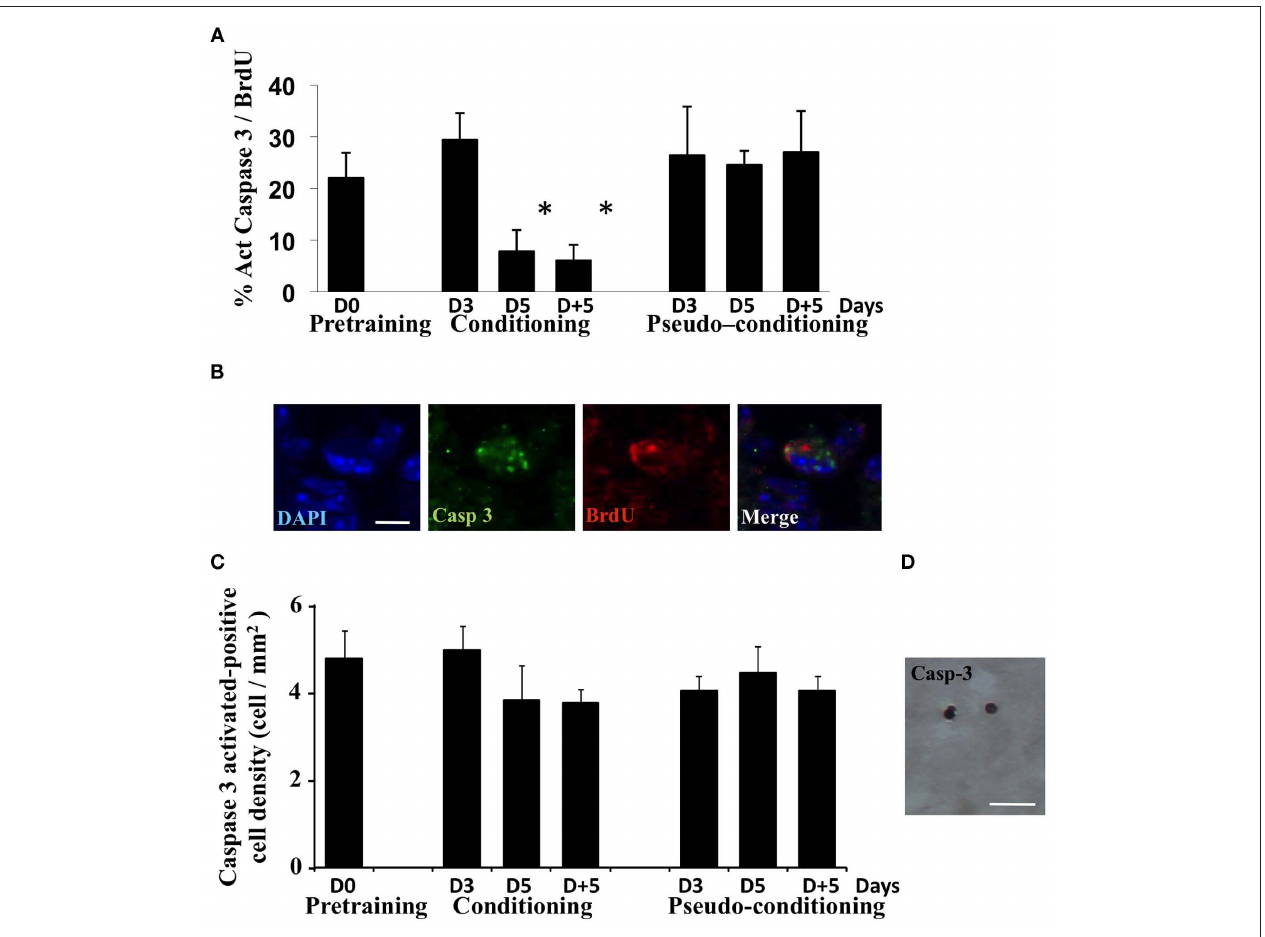
FigUre 3 | Analysis of cell death during olfactory conditioning. (A) Percentage of activated-caspase3/BrdU double-labeled cells in the GCL. * p < 0.05 for difference from all other groups. (B) Activated-caspase3/BrdU